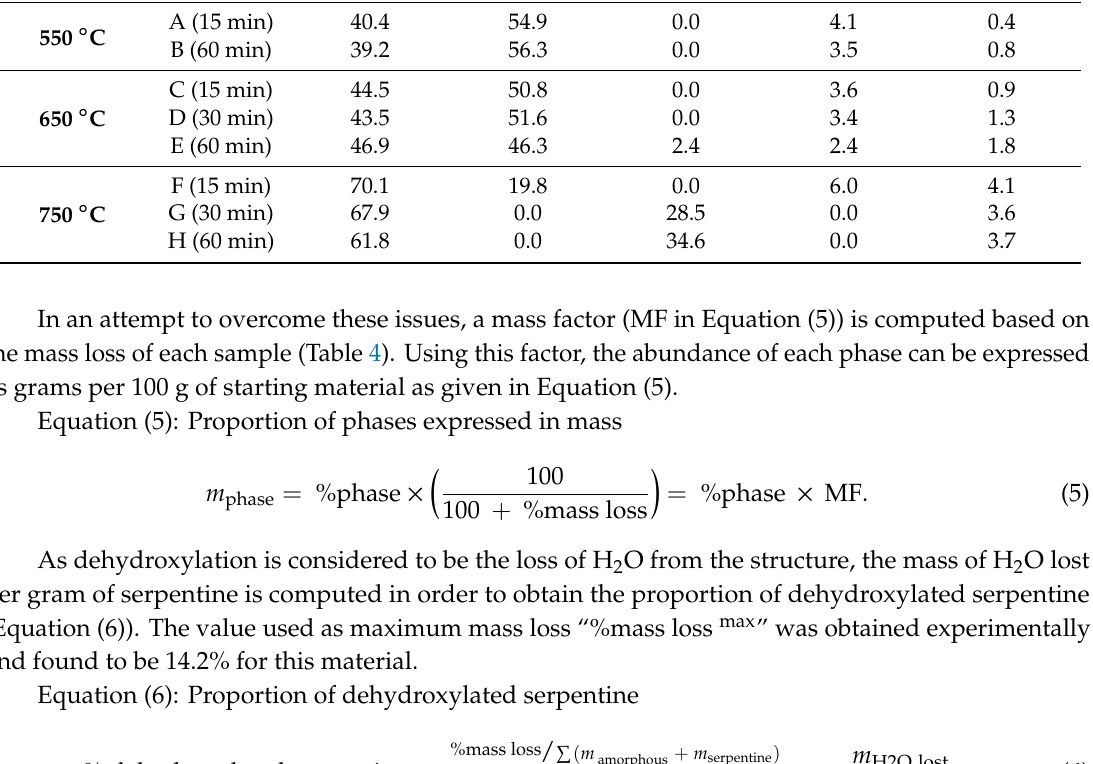
Table 5. Mineral composition using Rietveld refinements on XRD patterns, given in wt %. Amorphous Serpentine Forsterite Magnetite Hematite